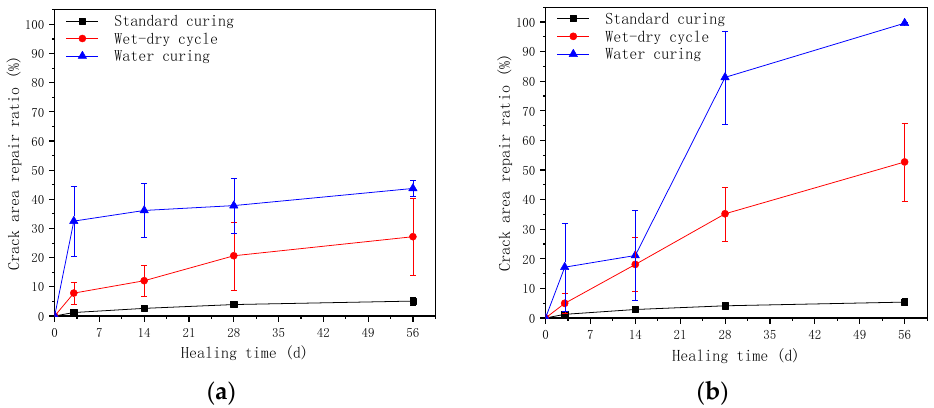
Figure 4. Crack area repair ratio of mortars under different exposure environments: ( a ) control; ( b ) with bacteria. Three specimens were tested for each exposure environment.